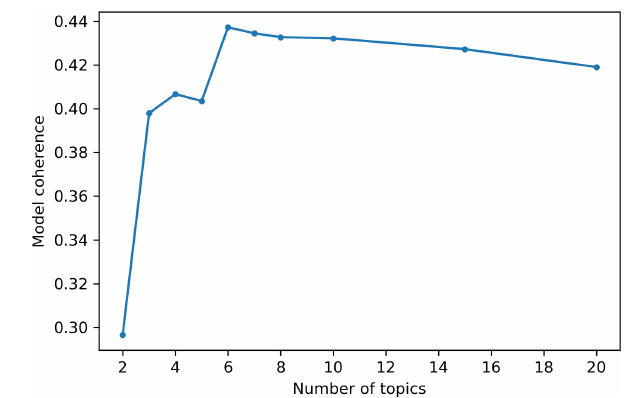
Figure 4. Evolution of overall model coherence according to the number of topics chosen to train the LDA model. The coherence metric is the C V described in Röder et al. (2015), which is a com- bination of a normalized pointwise mutual information coherence measure, cosine vector similarity and a Boolean sliding window of size